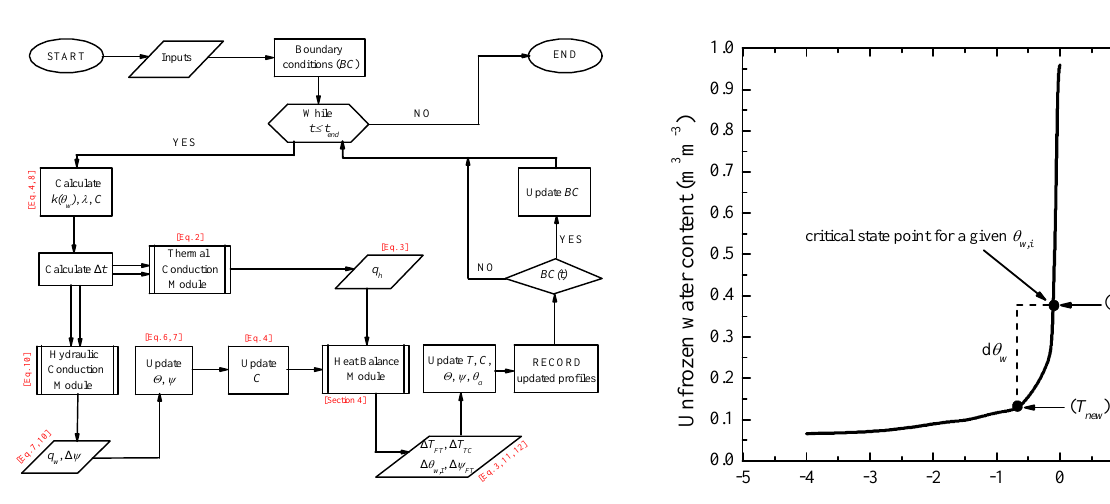
Figure 2. Flow chart describing the algorithm driving the coupled CA code. Subscripts TC, HC and FT refer to changes in physi- cal quantities due to thermal conduction, hydraulic conduction and freeze–thaw processes respectively. Hydraulic conduction and ther- mal conduction are two different CA codes coupled through up- dating of volumetric heat capacity and the freeze–thaw module to simulate the simultaneous heat and water movement in soils. Cor- responding equations or sections containing module description are shown in red text in squared brackets.